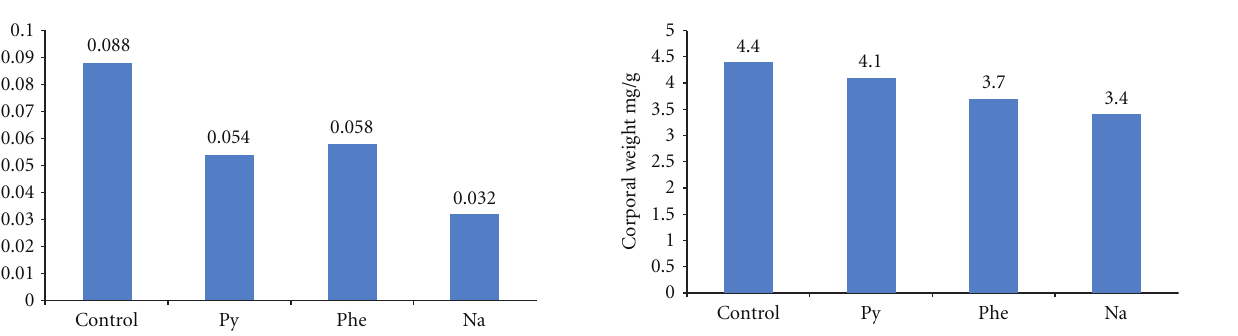
Figure 5: Mean growth rate of L. vannamei exposed to PAHs for 21 days.